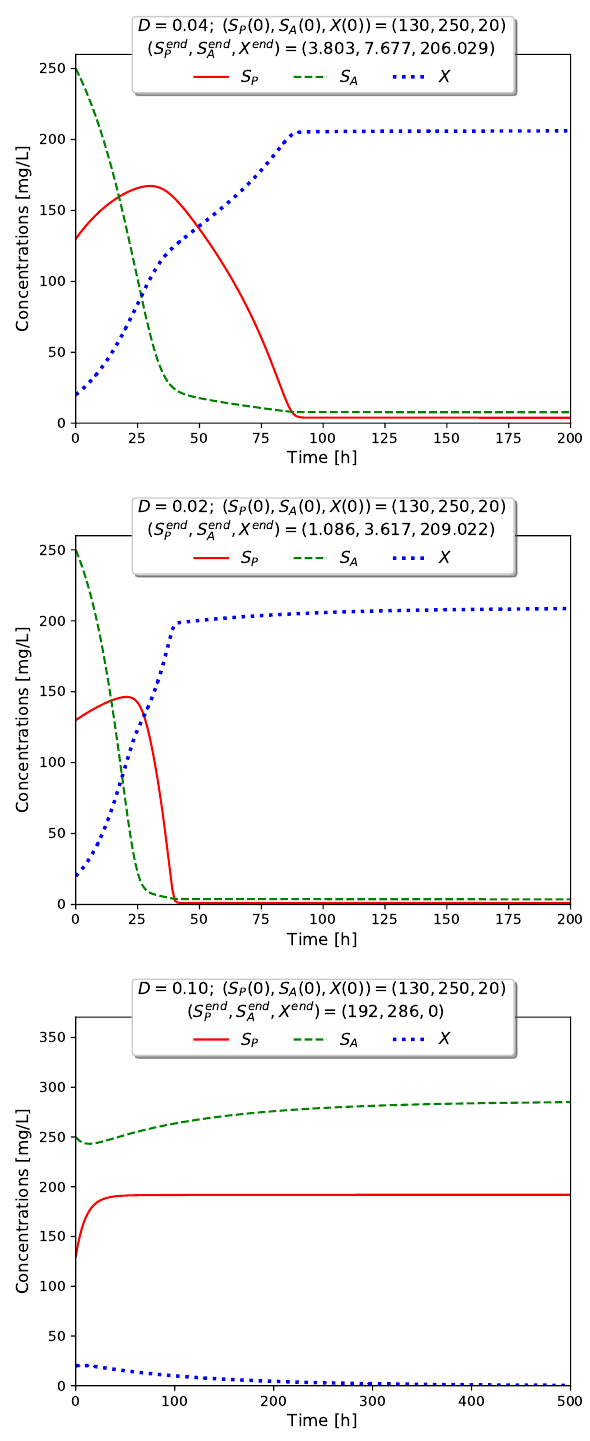
Figure 4. Solutions of system (1)–(3) for Examples 1–3, from top to bottom